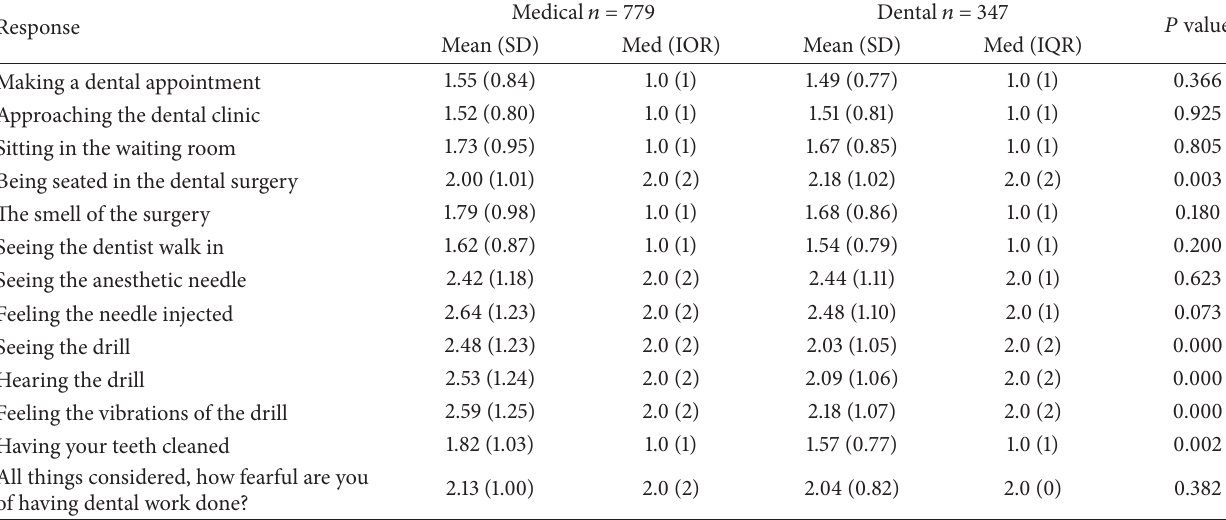
Table 2: Kleinknecht’s score of fear, anxiety, and unpleasantness when confronted with dental activities.